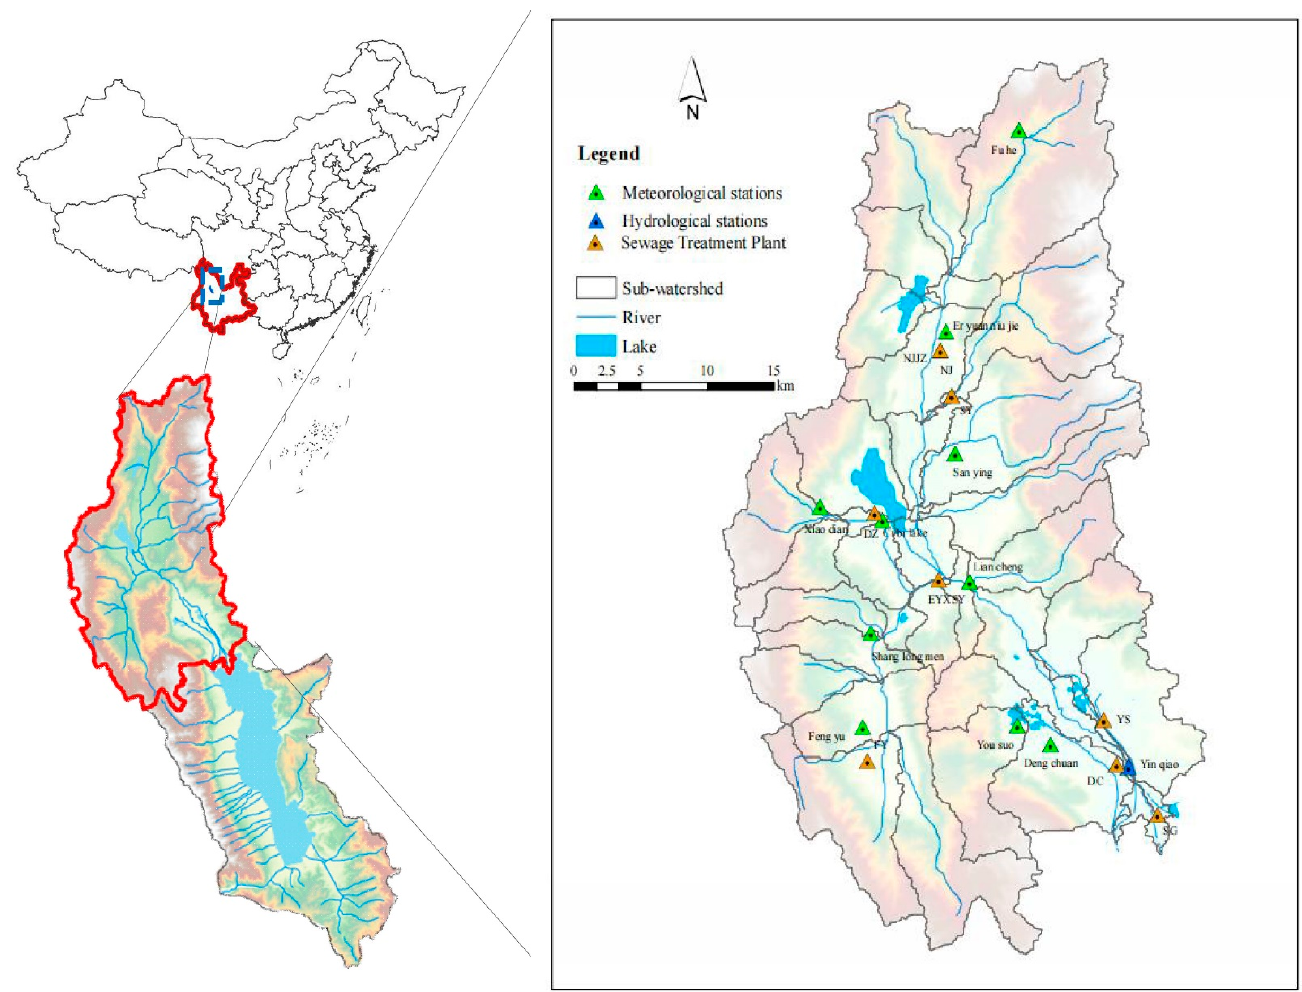
Figure 1. The location of NELB in the watershed.